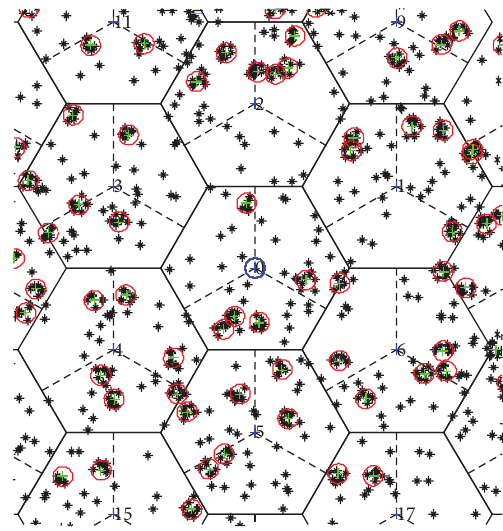
Figure 4: Cell layout and user distribution in hotspot